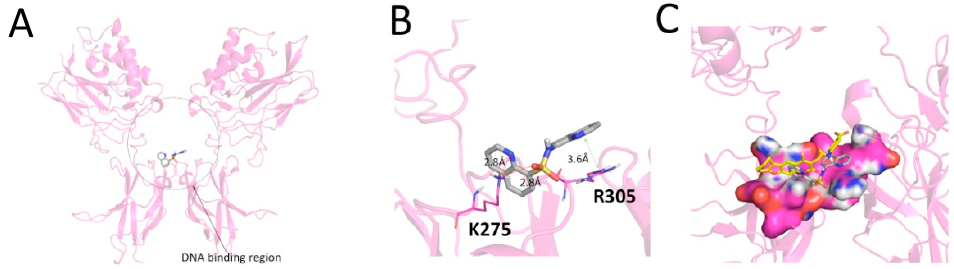
Figure 5. Results of docking simulation between compound 5 and NF- κ B. Compound 5 was docked in NF- κ B using the previously reported method. ( A ) Docking pose of inhibitor (gray carbon colored stick) in NF- κ B (pink ribbon). ( B ) Details of the binding mode. Compound 5 established two H-bonds with lysine 275 and a face-to-face interaction with arginine 305. The distance and the interaction geometry between quinoline and arginine are consistent with literature data. ( C ) Comparison between the binding mode, previously reported, for psoralene compounds and the herein considered compound 5 .